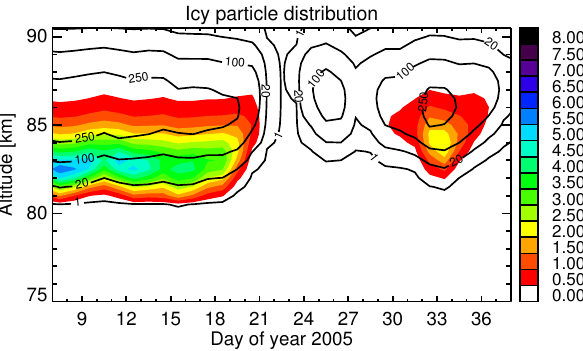
Fig. 9. Same as Fig. 5 but here for a model run with 5.5ppm H 2 O at 75km corresponding to the MIPAS value.